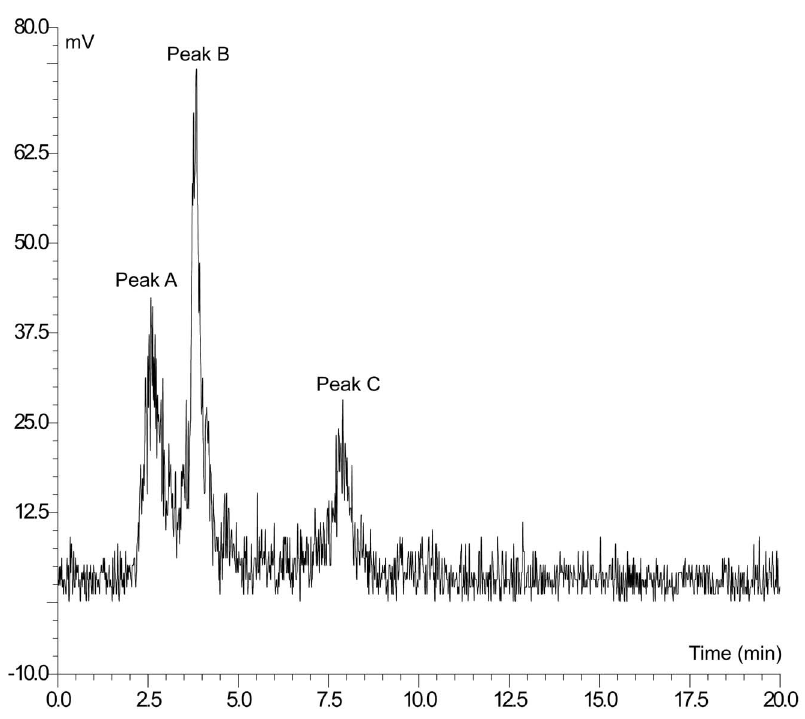
Fig. 7. Representative HPLC radiochromatogram showing radiolabelled parent compound and metabolites in rat plasma after [ 125 I]WYE-230949 injection. Polar and intermediate metabolites are shown as Peak A (RT 5 2.58 min) and peak B (RT 5 3.84 min), respectively. Peak C (RT 5 7.89 min) co-eluted with cold WYE230949 and was identified as parent compound, [ 125 I]WYE-230949.